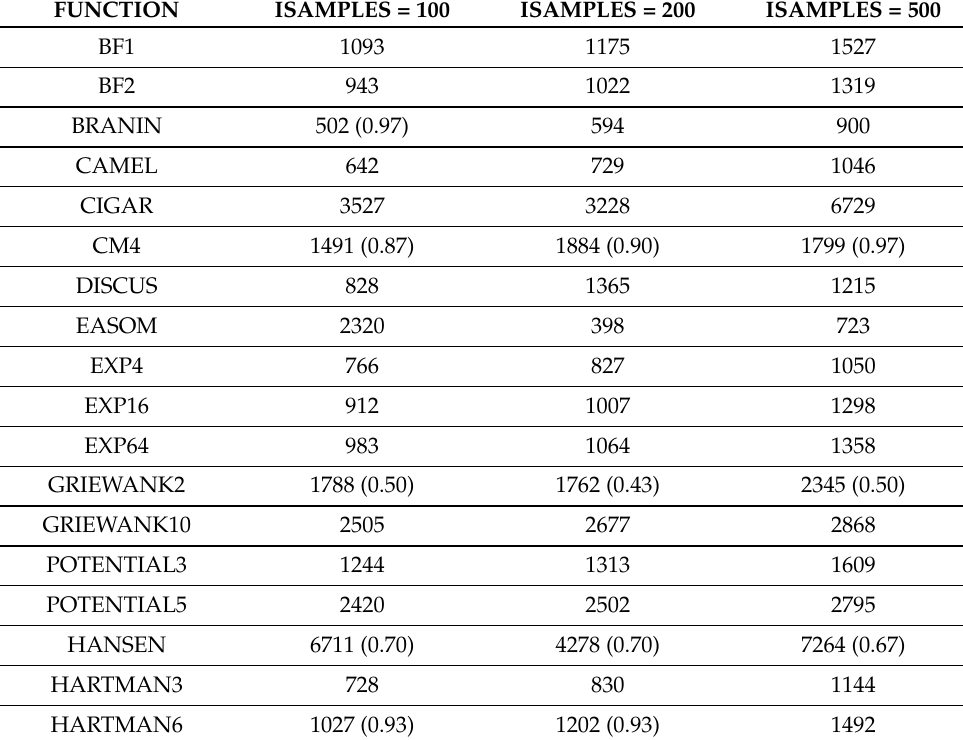
Table 4. Experimental results for the proposed method with N =